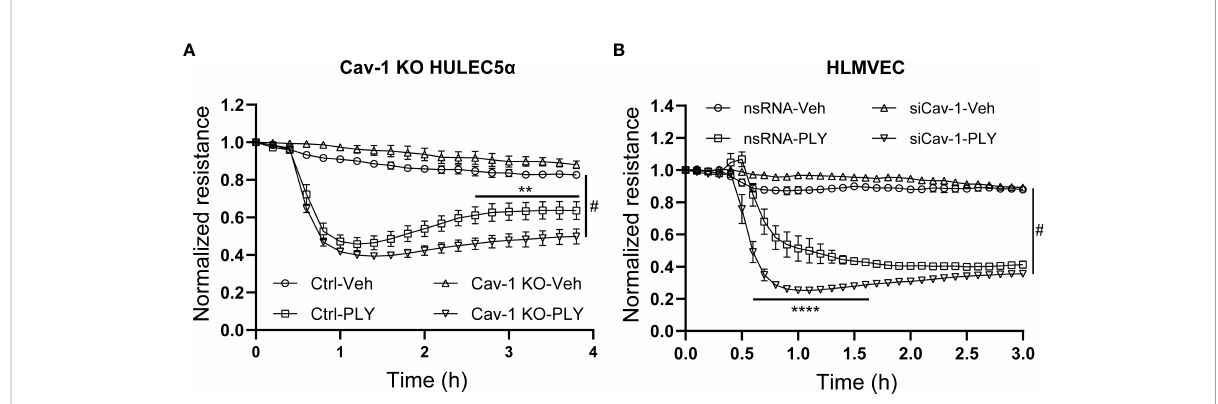
FIGURE 5 Knock-out or silencing of Cav-1 facilitates PLY induced barrier dysfunction in human lung microvascular endothelial cells. (A) Control and Cav-1 knockout HULEC5 a cells were treated with PLY and barrier function assessed by changes in TER. (n=3). **P<0.01 control-PLY vs Cav-1 KO-PLY, # P<0.0001 when compared to vehicle control. (B) HLMVECs were treated with non-targeting (nsRNA) or caveolin-1 speci fi c silencing RNA (siCav-1) for 72 hours and TER was measured upon challenge with PLY (60 ng/mL), (n=3-4). ****P<0.0001 control-PLY vs siCav-1-PLY, # P<0.0001 when compared to vehicle control. Two-way ANOVA (with Tukey ’ s multiple comparisons test).